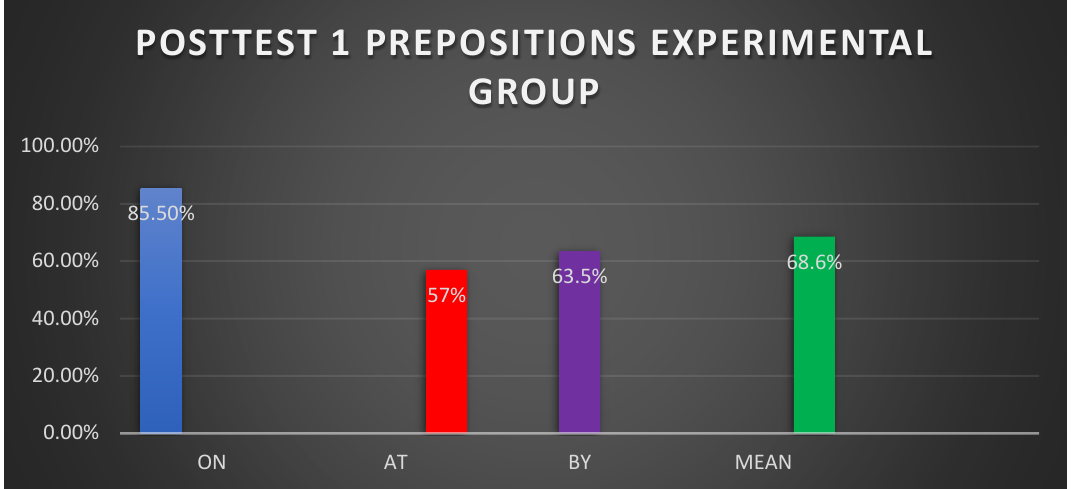
Figure 5. Experimental group Posttest 1 prepositions and means.